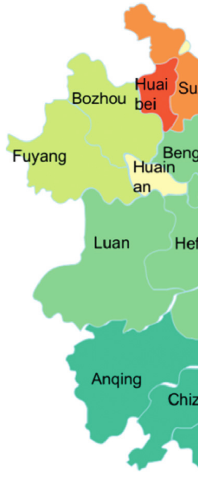
Figure 10: Scale efficiency 2015.